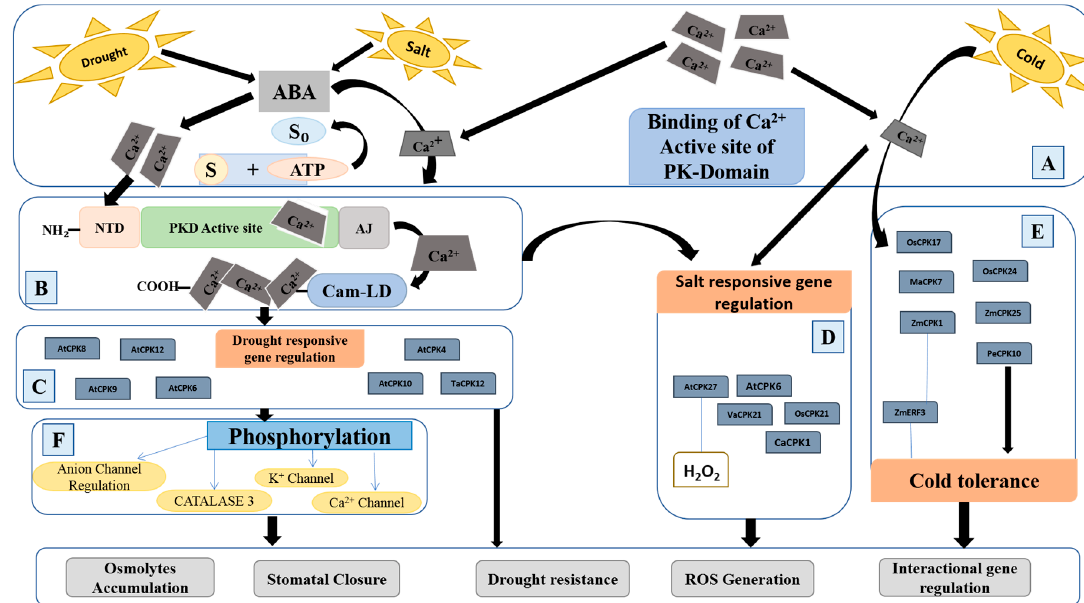
Figure 2. Role of di ff erent CPKs under various abiotic stresses; ( A ) Ca 2 + -dependent ABA-mediated drought and salt stress signal recognition by CPKs; ( B ) Ca 2 + binding at the active site of protein kinase domain (PKD); ( C ) some drought-responsive genes involved in metabolite regulation and signal transduction pathways; ( D ) some salt-responsive genes and their role in antioxidant production (i.e., H 2 O 2 ), as well as ROS detoxification; ( E ) some cold stress-responsive genes and their interaction genes activation; and ( F ) phosphorylation events controlling the anion channel regulation, K + -inward channel regulation, Ca 2 + -concentration, and channel regulation in the cell, and ABA-mediated CATALASE 3 regulation in plant